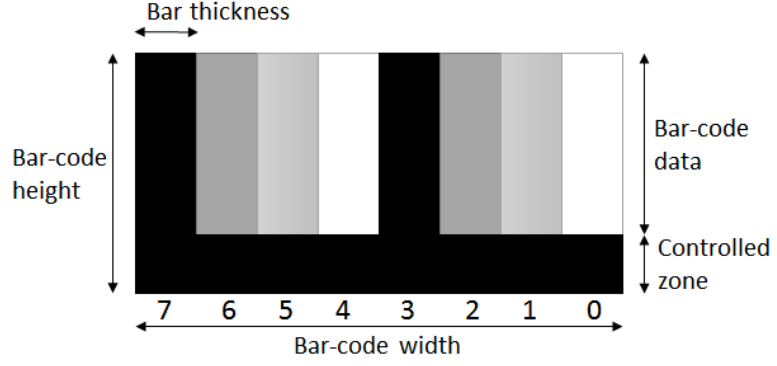
Figure 7. Proposed multi-level bar-code (version 1).